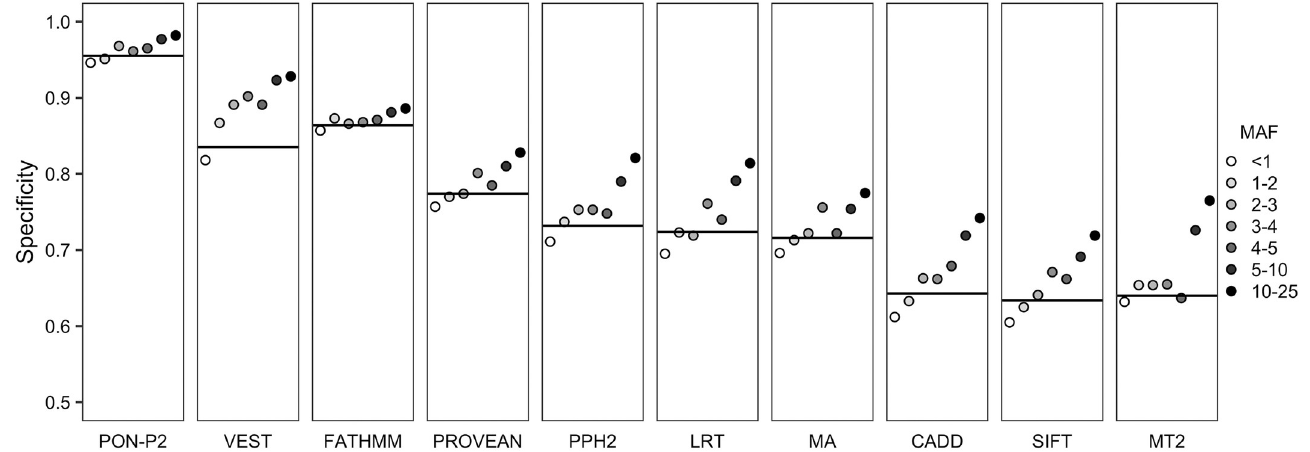
Fig 1. Performance of variant tolerance predictors. Specificities of 10 prediction tools for variants with different AFs. The black horizontal line indicates performance for all variants (AF � 1% and < 25%). The variants with AF < 1% have low AF in the whole dataset but have higher AF in at least one of the populations. MA, MutationAssessor; MT2, MutationTaster2; PPH2, PolyPhen-2.